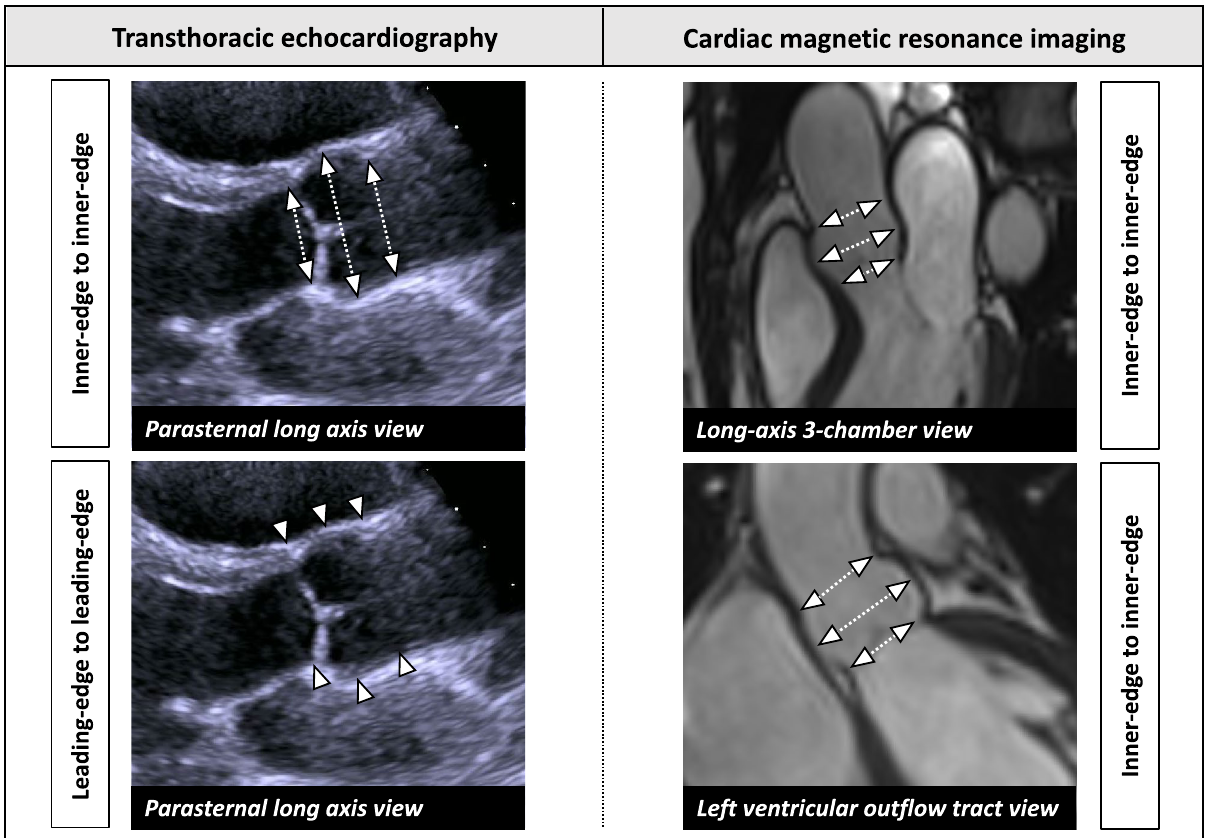
Figure 1. Measurements of the aortic root in TTE and CMR. Measurements were performed in end- diastole at the level of the aortic annulus, sinus of Valsalva and sinotubular junction. In TTE measurements were performed both from inner-edge to inner-edge (II) and from leading-edge to leading-edge. In CMR measurements were performed using the II